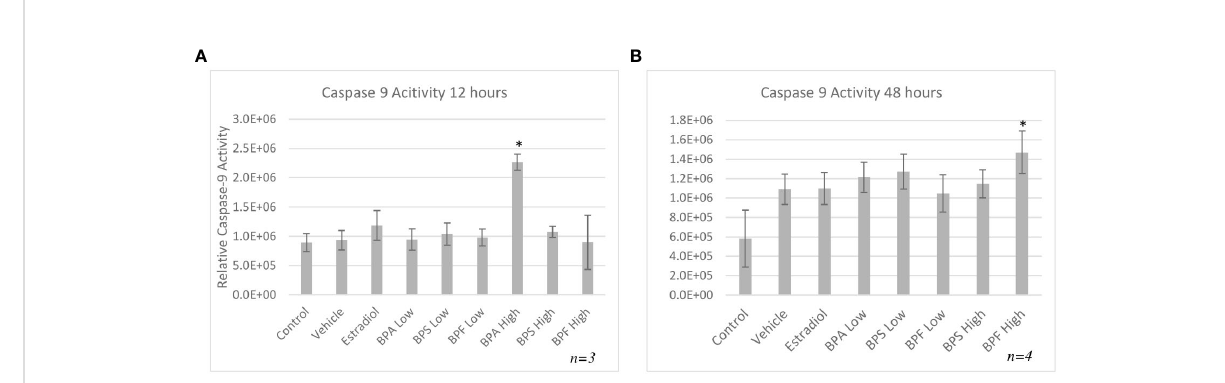
FIGURE 7 Activity of caspase-9 after 12 or 48 hours of treatment. Cells were treated with low dose (0.5 m g/mL) and high dose (50 m g/mL) BPA, BPS and BPF. (A) represents activity following 12 hours and (B) represents activity following 48 hours. *p<0.05 compared to controls was considered as statistically signi fi cant. Error bars represent +/-